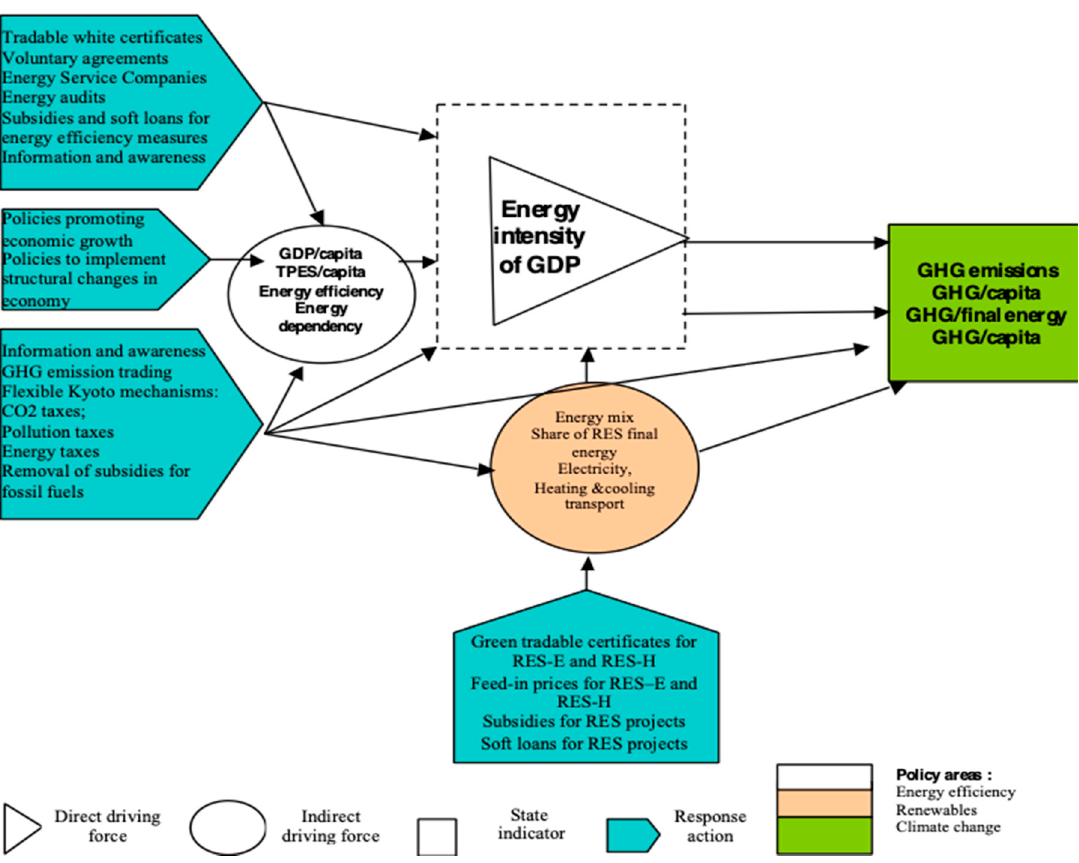
Figure 3. Indicators framework for analysis of GHG emission profiles and main drivers of GHG emissions. Source: created by authors based on [38].